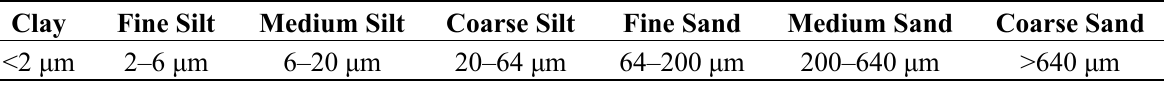
Table 1. Classification of particle sizes for the sediment samples of River Elbe and River